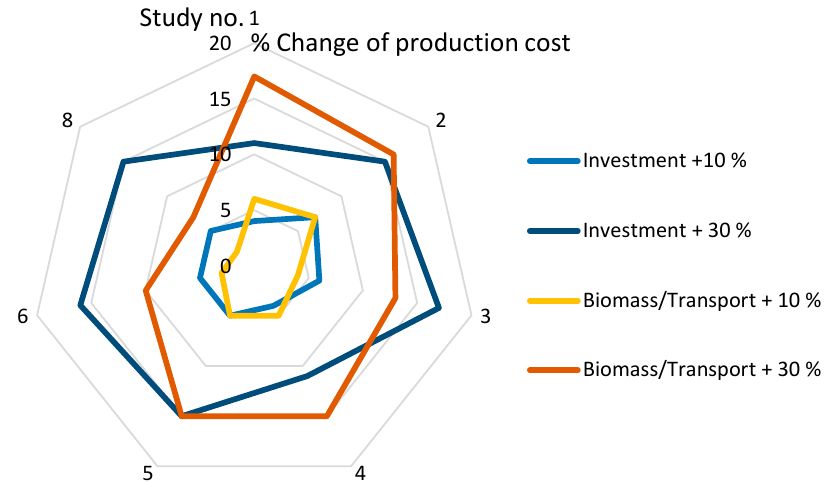
Figure 7. Change of production cost by increasing the investment and biomass/transportation costs by 10 and 30%.